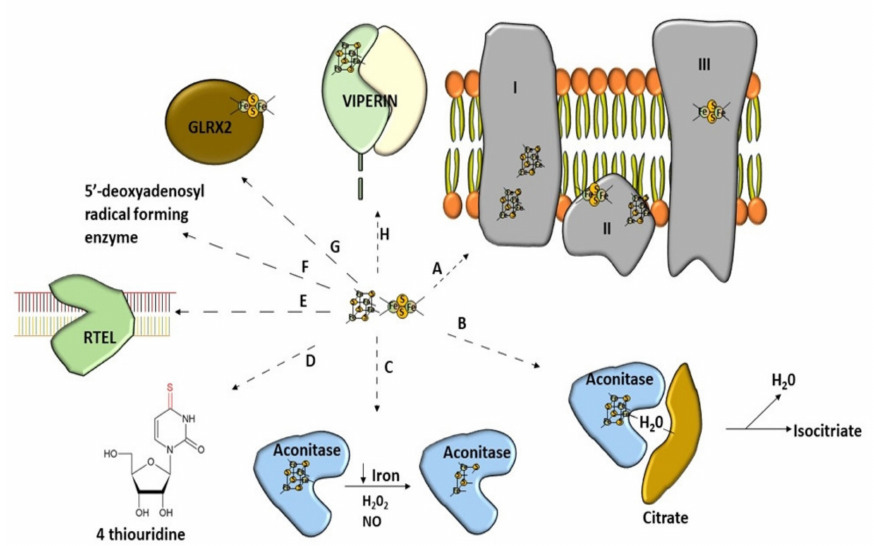
Figure 2. Wide range of use of [Fe–S] clusters. (A) Mitochondrial respiratory chain–NADH de- hydrogenase (complex I), succinate dehydrogenase (complex II), Cytochrome bc1 (complex III). (B) Non-redox catalysis (aconitase), (C) regulatory function of aconitase after oxidative stress, (D) involvement in tRNA modification, threonylcarbamoyladenosine tRNA methylthiotransferase (CD- KAL1), (E) participation of Fe–S cluster in genome integrity; RTEL (helicase-nuclease DNA2 and regulator of telomere length 1), (F) molybdenum cofactor biosynthesis protein 1 (MOCS1A, a member of the S-adenosylmethionine (SAM)-dependent enzyme family) is an enzyme using the Fe–S cluster to generate a 5 (cid:48) -deoxyadenosyl radical, (G) glutaredoxins with Fe–S clusters are involved in Fe–S cluster synthesis, (H) antiviral proteins using Fe–S cluster to perform their activity